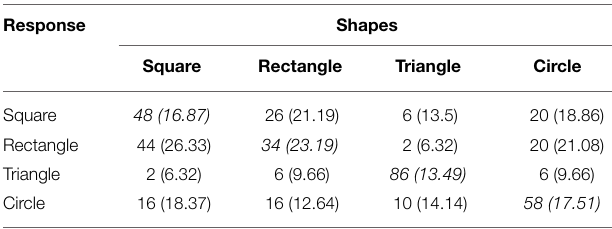
TABLE 1 | Response matrix for Experiment